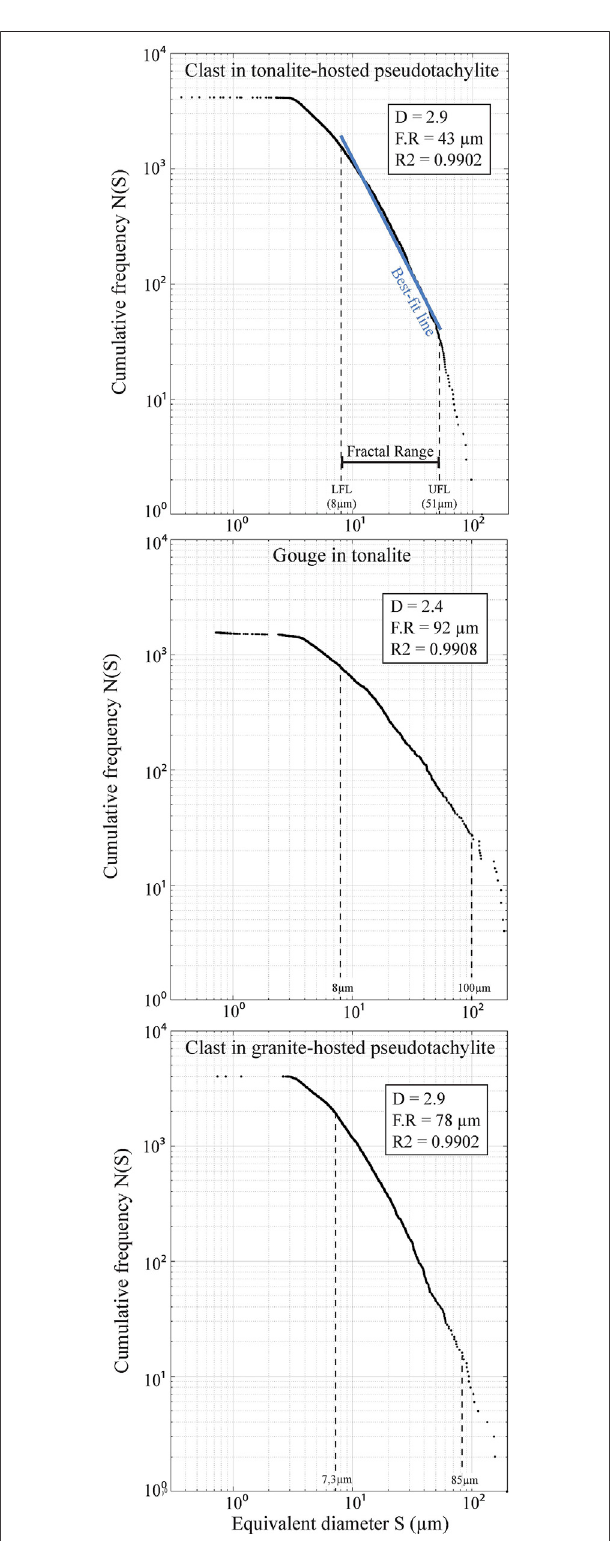
FIGURE3| Exampleofparticle size distribution plot. Log-log diagram of equivalent diameter (S) against cumulative frequency N(S) of clasts in